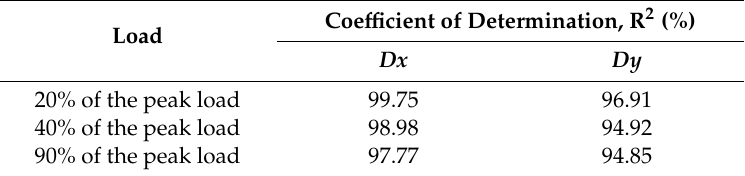
Figure 14. Changes in horizontal displacement ( Dx ) along the centerline: DIC vs. simulation results. Table 3. Coe ffi cient of determination of Dx and Dy between DIC and the simulation